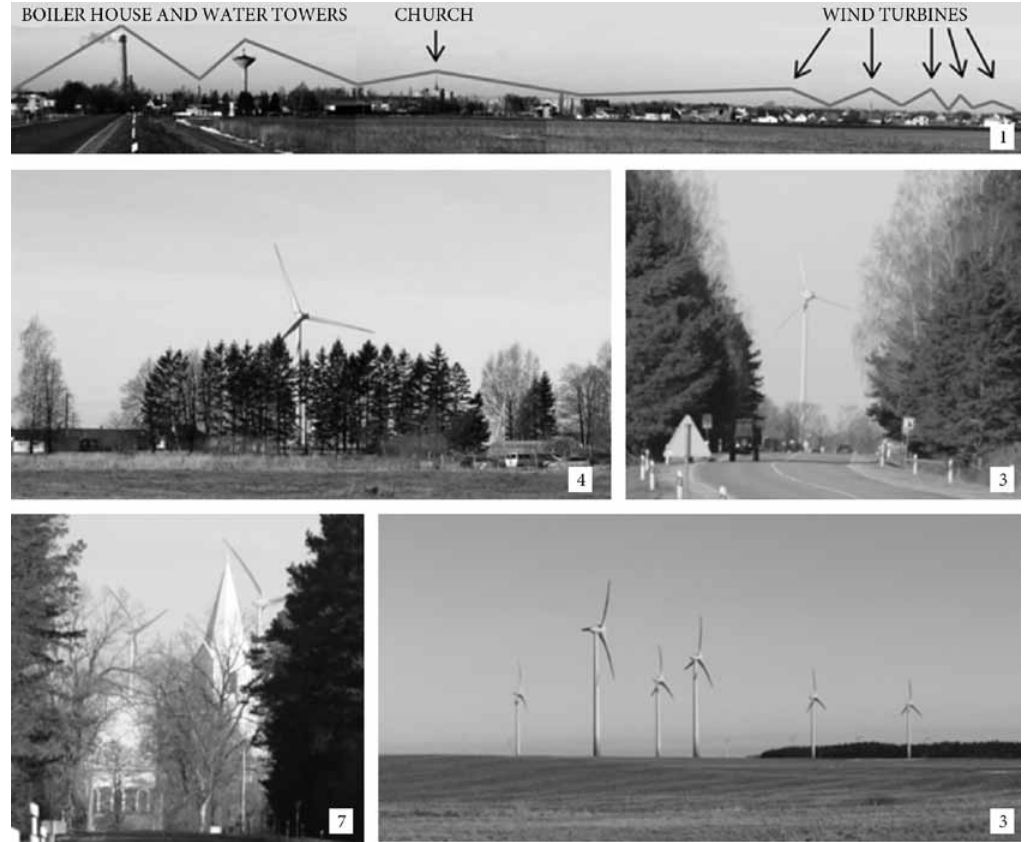
Fig. 4. Photos made from observation points No.: 1, 3, 4, 7 (photos by J. Abromas,